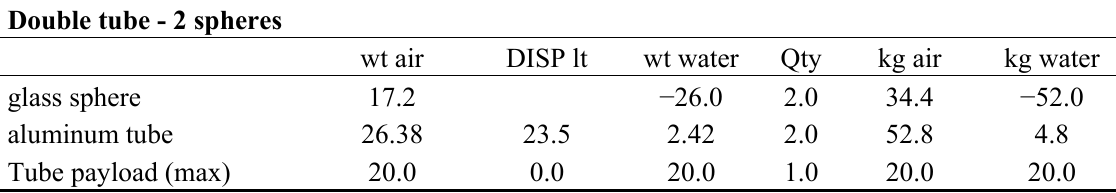
Table 2. Buoyancy calculations for new